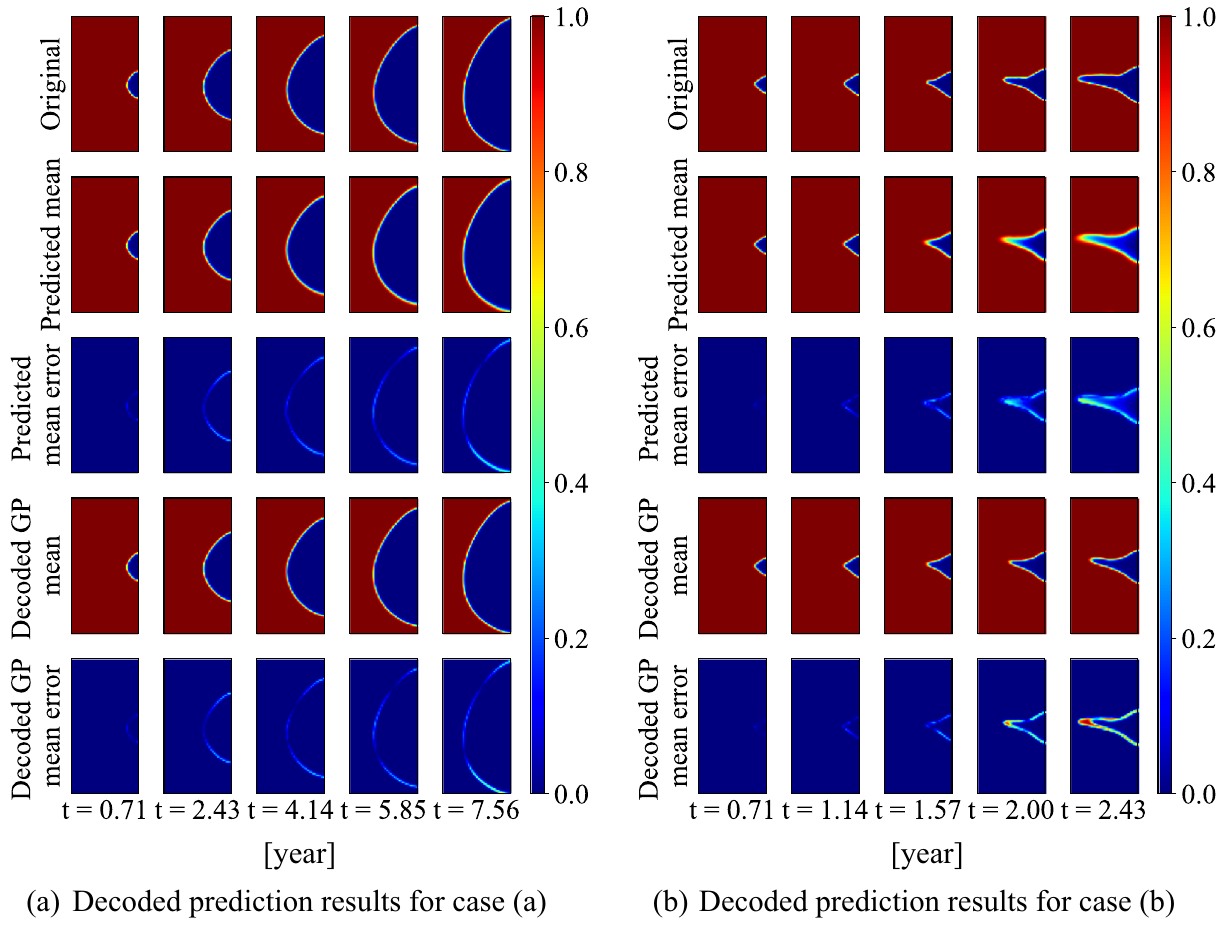
Figure 17. Multiple-step prediction result of the corrosion